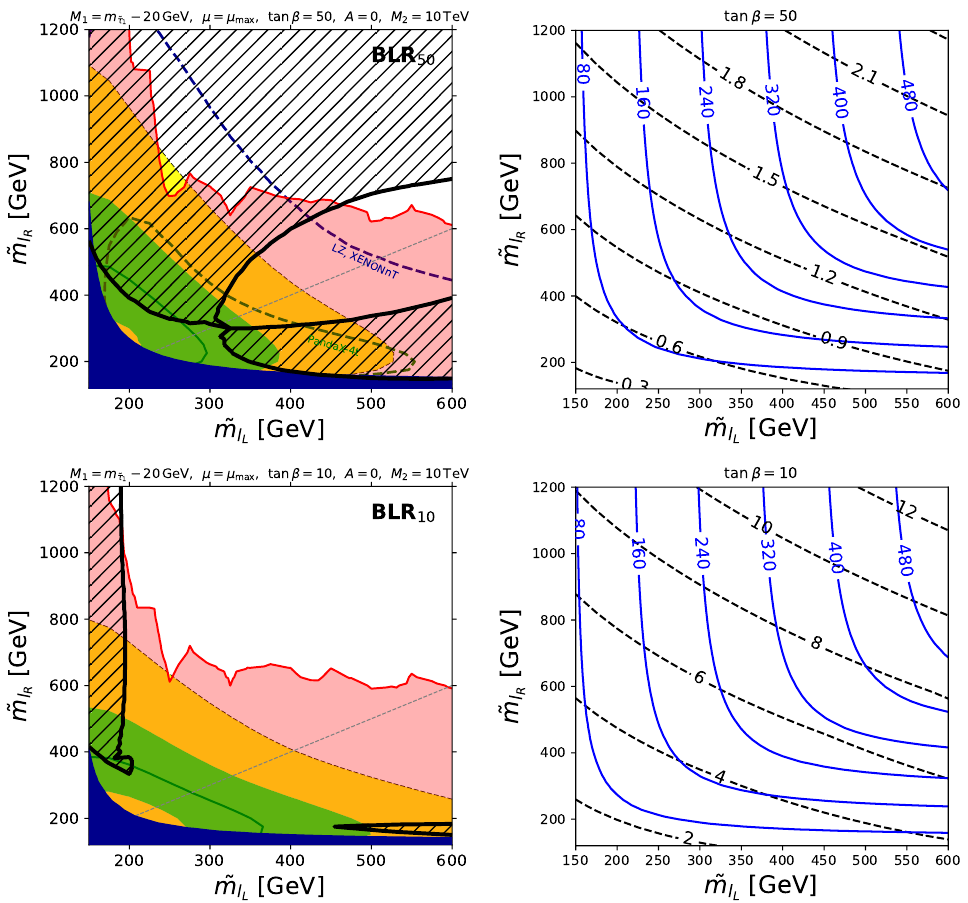
Figure 4 . Results for MSSM BLR 50 (upper row) and BLR 10 (lower row) planes. Plots on the left hand side show parameter regions and appropriate experimental constraints. Region of parameter space allowed by the latest a experimental results [4] is depicted with green and yellow µ bands, corresponding to one and two sigma agreement respectively. Hatched region is excluded by dark matter abundance criterion. Red shaded region is excluded by LHC constraints. Dark blue shaded area is excluded by LEP stau mass bound [87]. Expected exclusion range by future DDMD experiments is also shown with appropriately labelled contours. Plots on the right hand side of the figure show Bino mass (blue) and µ parameter (dashed black) values, which are implicitly fixed by other